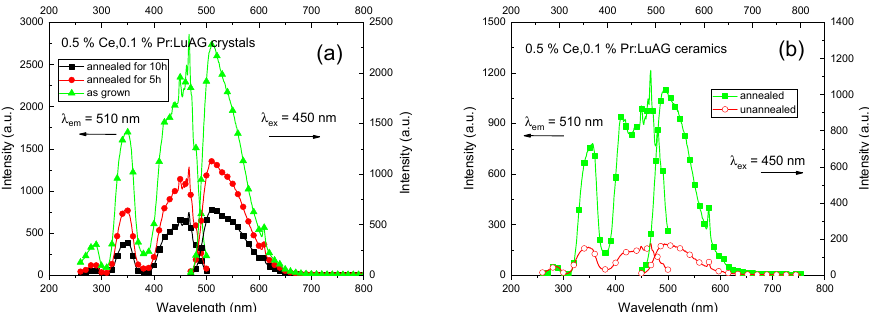
(2 mm thickness) and ceramics (1.2 mm thickness).